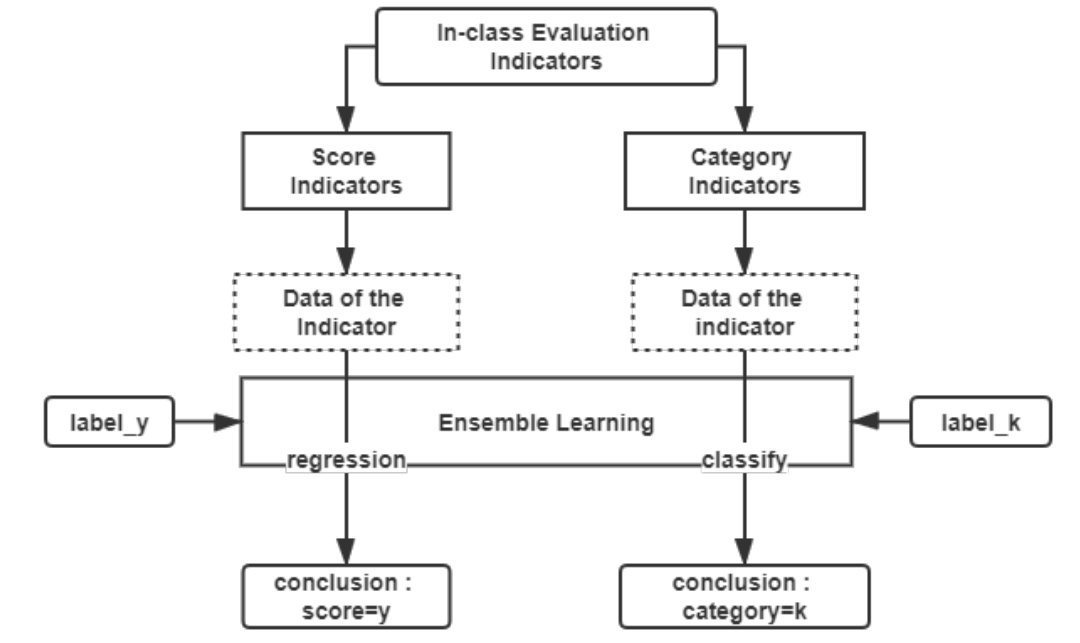
Figure 6. The process of ensemble learning module. Table 2. The calculation of indicators in the ensemble learning module.